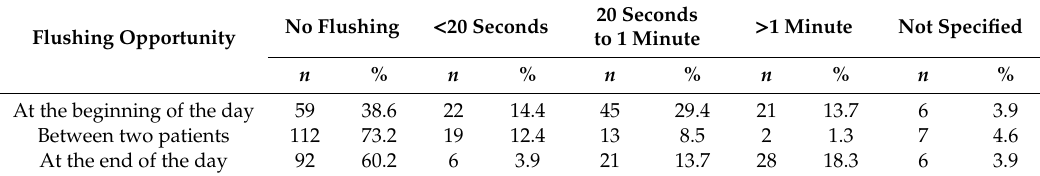
Table 1. Flushing times of the dental unit waterlines in 153 dental o ffi ces studied in Eastern France in 2016.